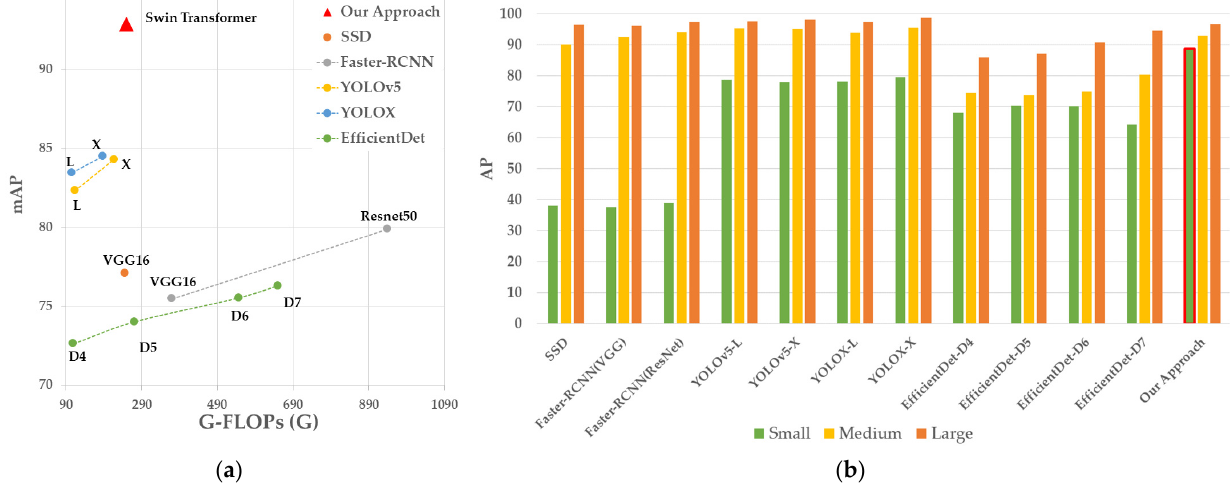
Figure 16. A comprehensive comparison of the models, ( a ) G-FLOPs(G) vs. mAP, ( b ) detection of the small, medium, and large instances, is shown in Table 6 for details.